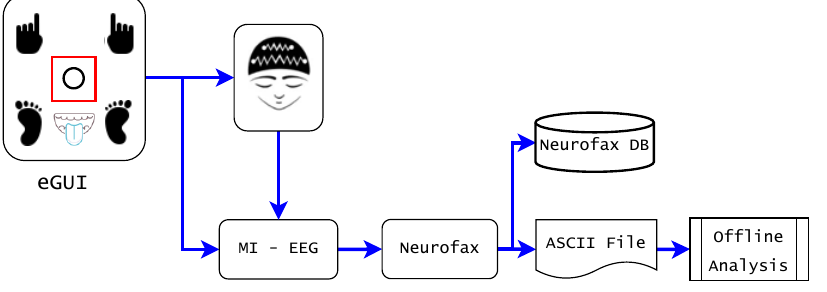
Figure 3. Overview of the EEG acquisition and processing in the experimental paradigm. The red rectangle on the eGUI moves over the specific limb icon as a visual stimulus to engage the respective mental task of imagined movement. MI–EEG signals from six mental states were recorded by EEG-1200 equipment and processed using Neurofax recording software [40]. In addition, ASCII data were converted into Matlab files for further